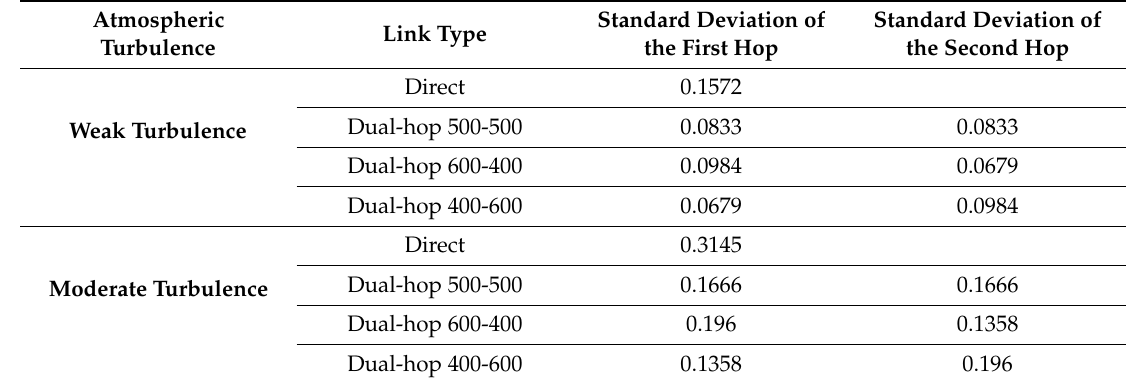
Table 3. Standard deviation